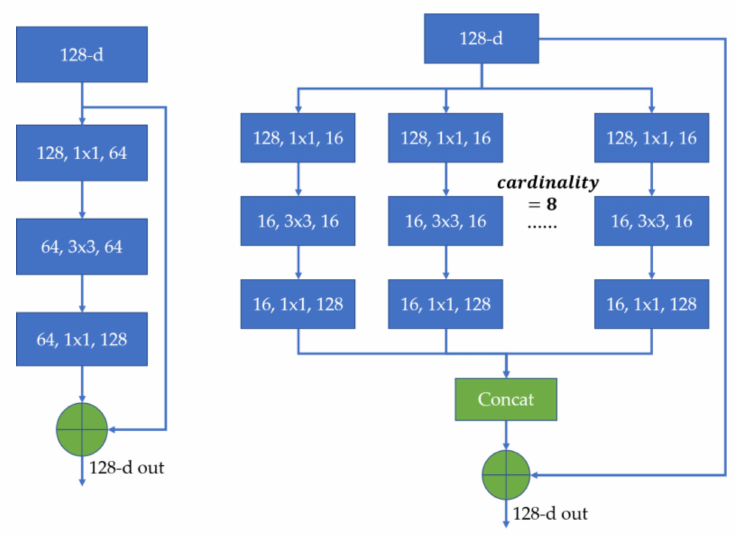
Figure 1. A block of ResNet (Left) and ResNeXt with cardinality = 8 (Right). A layer is shown as (# in channels, filter size, # out